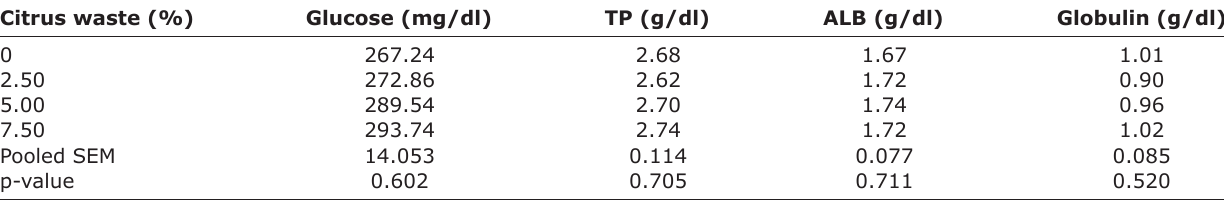
Table-1: Effect of feeding different levels of citrus waste on the blood parameters of broiler. Citrus waste